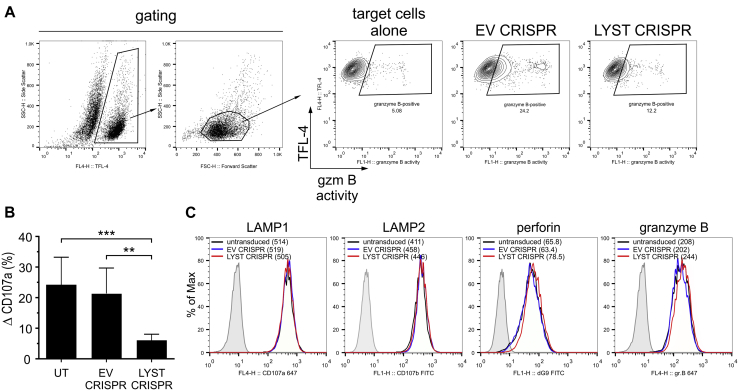
Degranulation ability of LYST-deficient NK cells. A, Delivery of granzyme B to target cells. 721.221 target cells were labeled with TFL-4 and a fluorogenic substrate of granzyme B and then mixed with EV or LYST CRISPR NK92mi cells. The increase in substrate fluorescence in TFL-4–positive target cells, indicating the activity of granzyme B, was monitored by using flow cytometry. Dot plots show gating strategies used and illustrate an example of the result. B, Assessment of degranulation. NK92mi cells, either untransduced (UT) or transduced with either EV or LYST CRISPR, were incubated alone or with 721.221 target cells for 60 minutes at 37°C. Cells were stained with anti-CD56 and anti-CD107a antibodies, and cell-surface expression of CD107a was determined by using flow cytometry. Change in CD107a cell-surface expression (ΔCD107a) was calculated as the percentage of CD107a-positive activated NK92mi cells after subtraction of the percentage of CD107a-positive NK92mi cells from the nonstimulated population. The graph shows mean values + SDs, as determined from 5 separate experiments. **P < .01 and ***P < .001, 1-way ANOVA. C, Intracellular levels of lysosomal proteins. NK92mi cells, either untransduced or transduced with EV or LYST CRISPR constructs, were fixed, permeabilized, and then stained with either anti–LAMP1–Alexa Fluor 647, anti-LAMP2–fluorescein isothiocyanate (FITC), anti-perforin–FITC, or anti–granzyme B–Alexa Fluor 647 antibodies. Cells were then analyzed by using flow cytometry for total levels of the indicated proteins. Histograms show a typical result from 2 independent experiments. Numbers in parentheses indicate median fluorescence intensity values for indicated protein staining.